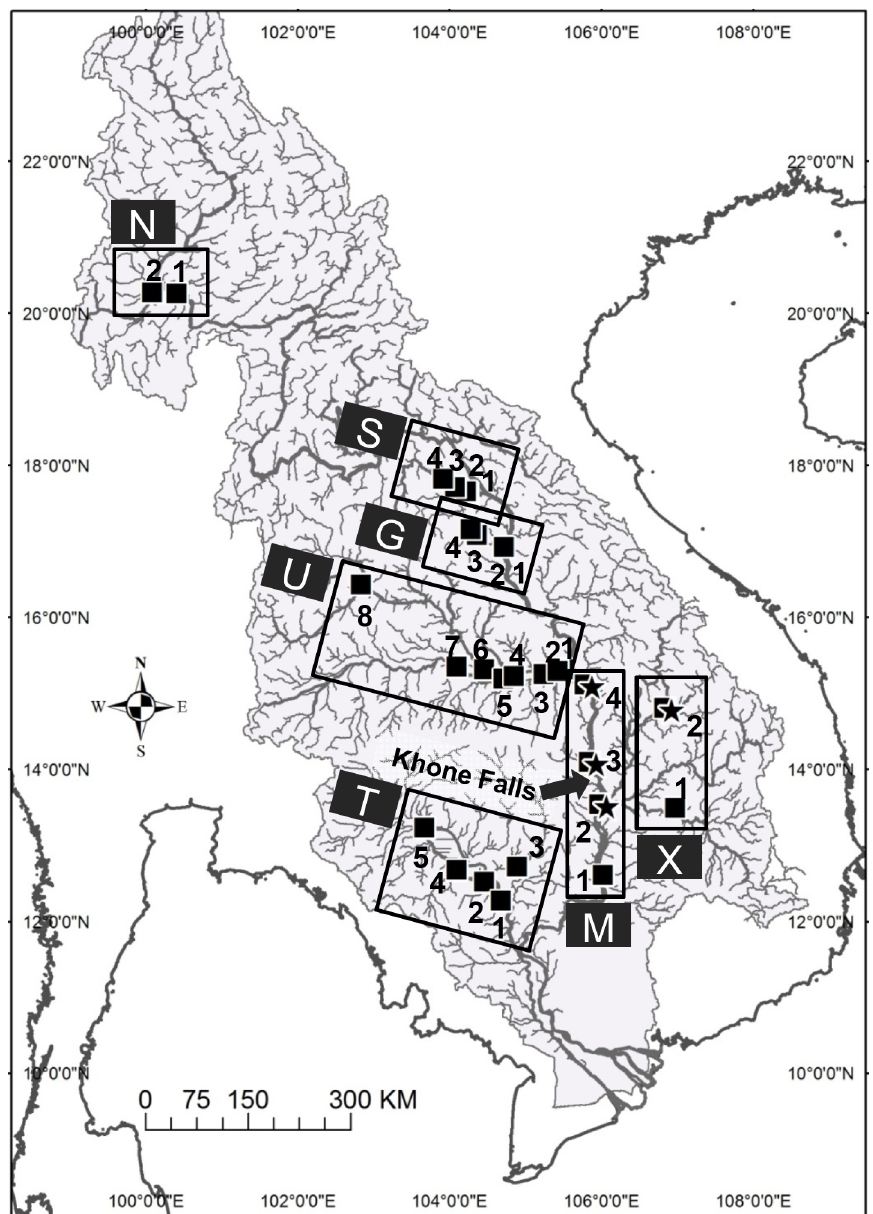
Figure 1. Fish sampling sites in the Mekong River basin. Black square: Henicorhynchus siamensis . Star: H. lobatus . A total of 29 sites are serially numbered toward upstream within each of seven regions: N= Thai North, S= Songkhram, G= Gam, U= Mun, X= Xekong, T= Tonle Sap and M= Mekong mainstream (MM). Location of the Khone Falls is indicated.